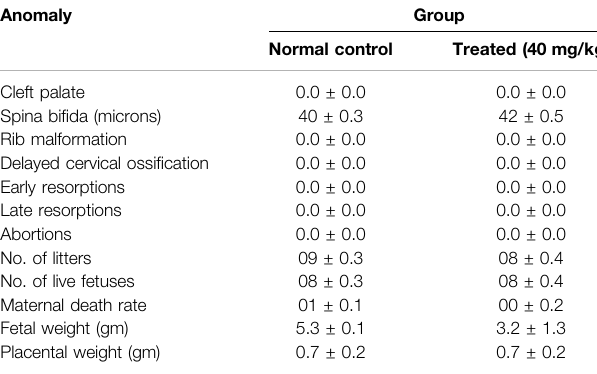
TABLE 7 | Effect of SF5 treatment (40 mg/kg) on morphological changes in developmental toxicity. Anomaly Group Normal control